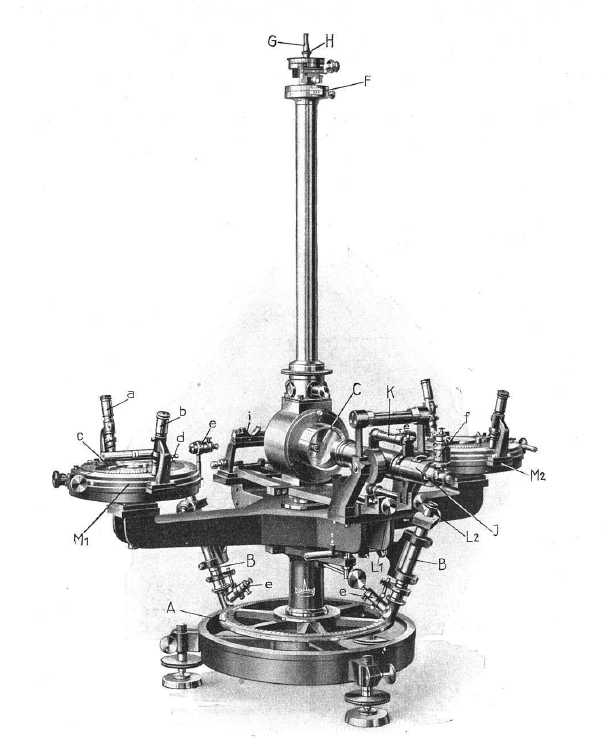
Figure 8. Normal theodolite after Adolf Schmidt. Source: Bock and Schmidt